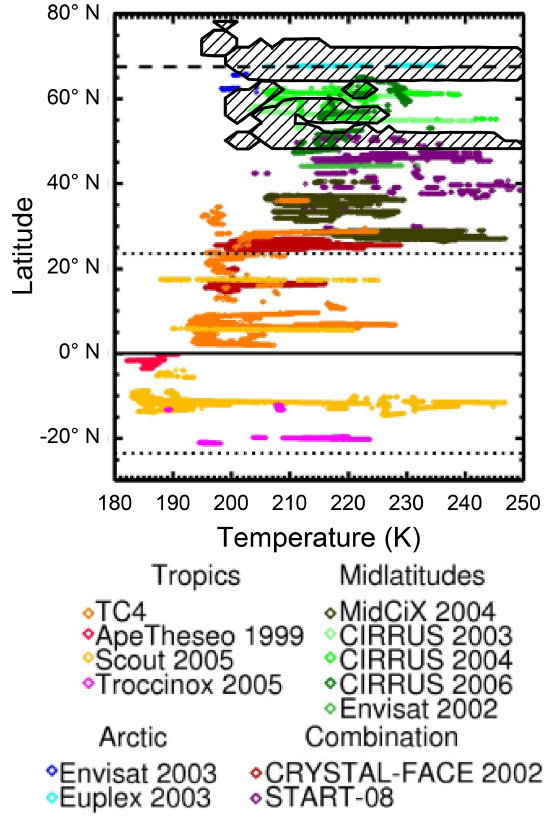
Figure 3. The black contour and diagonal stripes sketch the cov- erage of cirrus measurements during POLSTRACC with respect to latitude and temperature. For this work, the original of this figure from Luebke et al. (2013) is adapted, showing the coverage of air- borne in situ cirrus missions from the